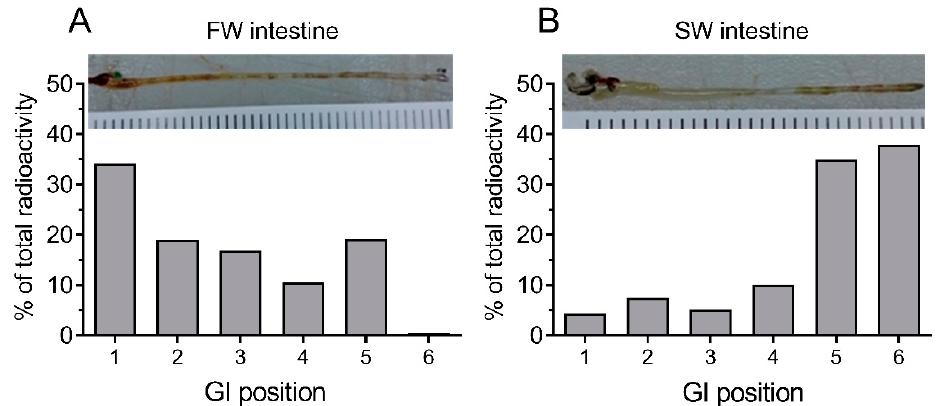
Figure 2. Distribution of radioactivity longitudinally in the gastrointestinal (GI) tract of fish allowed to drink 51-Cr-EDTA traced FW ( A ) or SW ( B ) water for 3 h. After incubation, the entire GI tract was ligatured into 0.5 cm segments and each segment was then transferred to a scintillation vial and scanned for radioactive content. The entire intestine was approximately 3 cm in length, as shown in the inserted photographs.